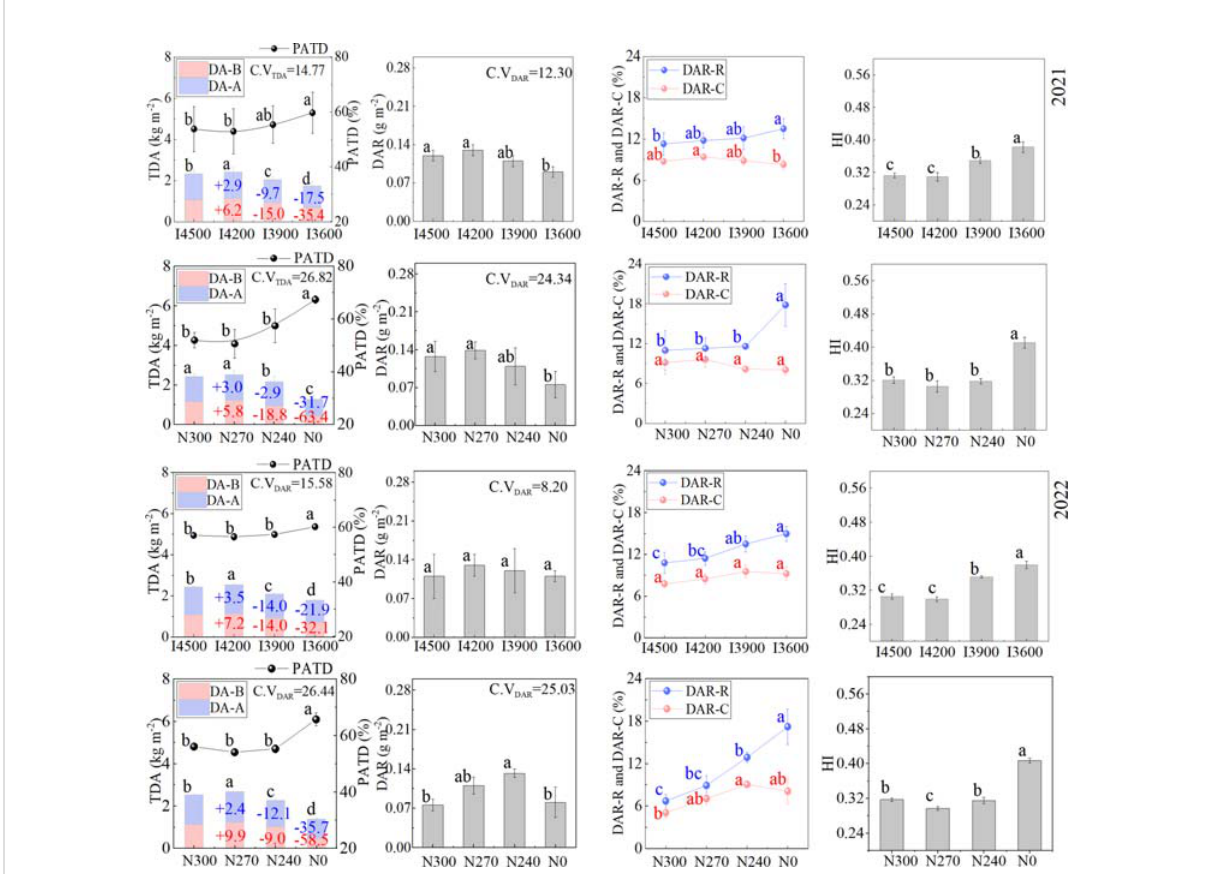
FIGURE 4 Effects of irrigation and nitrogen levels on biomass accumulation and redistribution in wheat. I4500, I4200, I3900, and I3600 indicate 4500, 4200, 3900, and 3600 m 3 ha − 1 irrigation levels, respectively. N300, N270, N240, and N0 indicate 300, 270, 240, and 0 kg ha − 1 nitrogen levels, respectively. TDA: the total dry matter accumulation at maturity, DA − B: dry matter accumulation before anthesis, DA − A: dry matter accumulation after anthesis, PATD: the ratio of DA − A to TDA, DAR: DA − B redistributed into grains after anthesis, DAR − R: the rate of DAR to grains, DAR − C: the contribution of DAR to grains, HI: the harvest index. C.V TDA and C.V DAR indicate the coef fi cient of variation in TDA and DAR among the irrigation and nitrogen levels, respectively. The numbers in the red and blue columns indicate the percentage change in DA − B and DA − A under a given treatment compared with the traditional irrigation (I4500) and nitrogen levels (N300). The lowercase letters refer to signi fi cant differences among the various irrigation and nitrogen levels at the 0.05